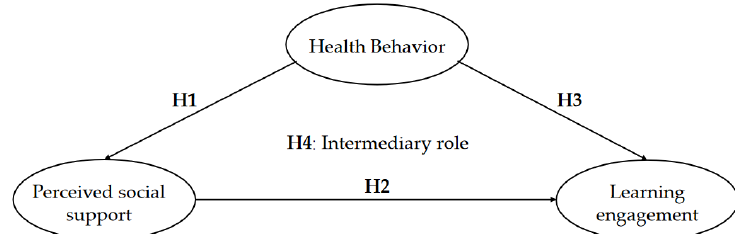
Figure 1. The hothesized model.